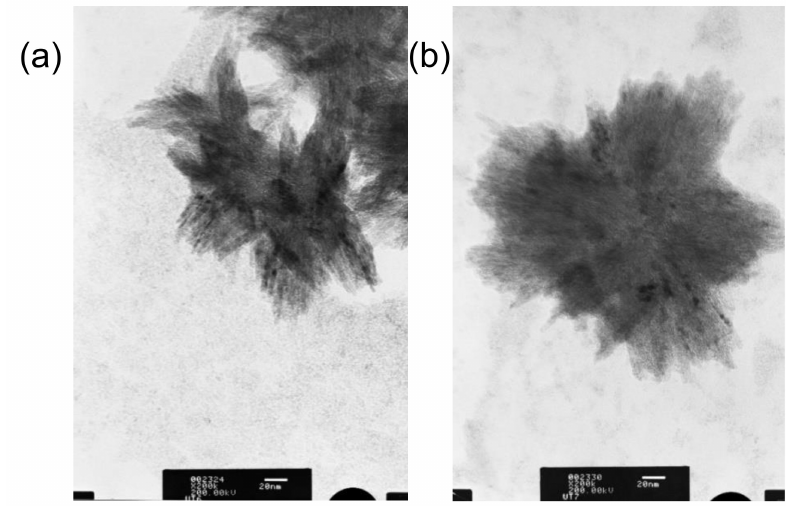
Figure 7. TEM images of the particles obtained with 0.66 M TiCl 4 and surfactant concentration of 1 wt % Span 80 in ( a ) hexadecane and ( b ) heavy oil.